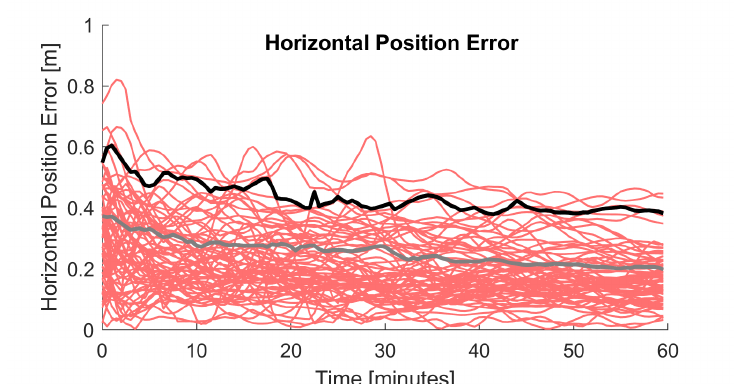
Figure 10. Horizontal position error for a PPP solution calculated on the next day for the station PFA3 (29–31 December 2019) using single-frequency GPS observations, the IGS ultra-rapid product, and Regiomontan. The 95% quantile is shown in black and the 68% quantile in